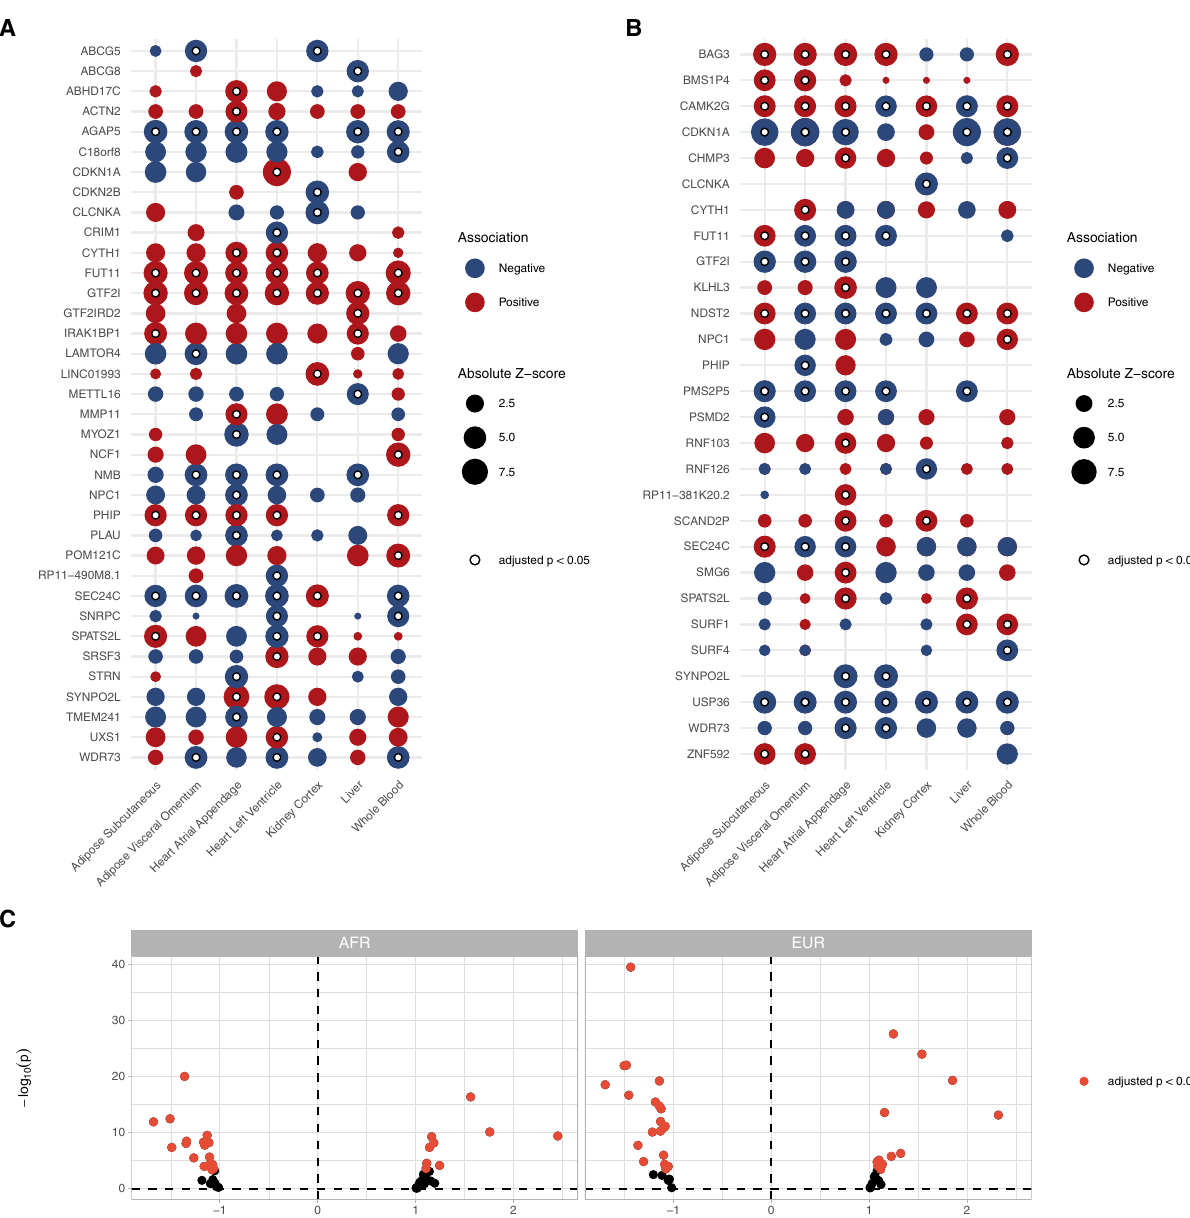
Fig. 6 | TWAS results. TWAS identi fi ed 36 distinct genes (representing 73 gene – tissue pairs) where expression was associated with adverse HF/structure/ function traits, and 28 distinct genes (across 111 splicing – tissue pairs) where spli- cing was associated with adverse HF/structure/function traits. A Dotplot depicting the gene – tissue pairs where gene expression was signi fi cantly associated with HF. B Dotplot depicting the gene – tissue pairs where transcript splicing was sig- ni fi cantly associated with HF. In A , B , the bubble size corresponds to absolute z - FKBP7, and B3GNT8. (Fig. 7A). Circulating SPON1 and FKBP7 have both been previously linked to atrial fi brillation, a known HF risk factor 68 , and SPON1 has been identi fi ed as a potential biomarker for HF hospitalization 69 .